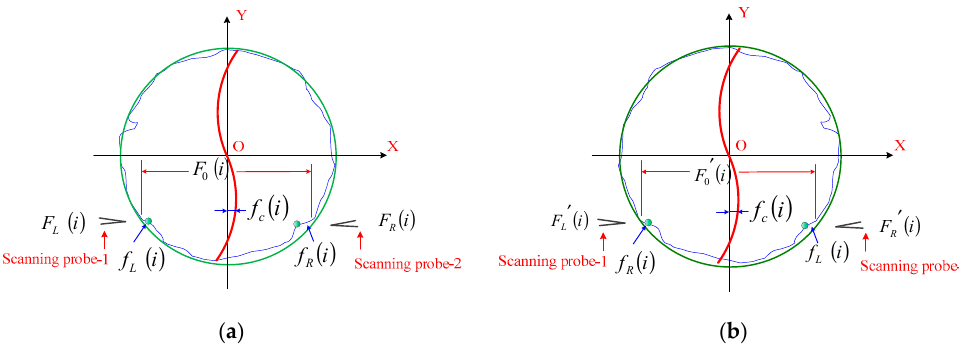
Figure 3. Measurement principle of two opposite cross-sectional profiles: ( a ) The measurement of a cross-sectional profile, ( b ) The measurement of the opposite cross-sectional profile after turning 180 degrees.